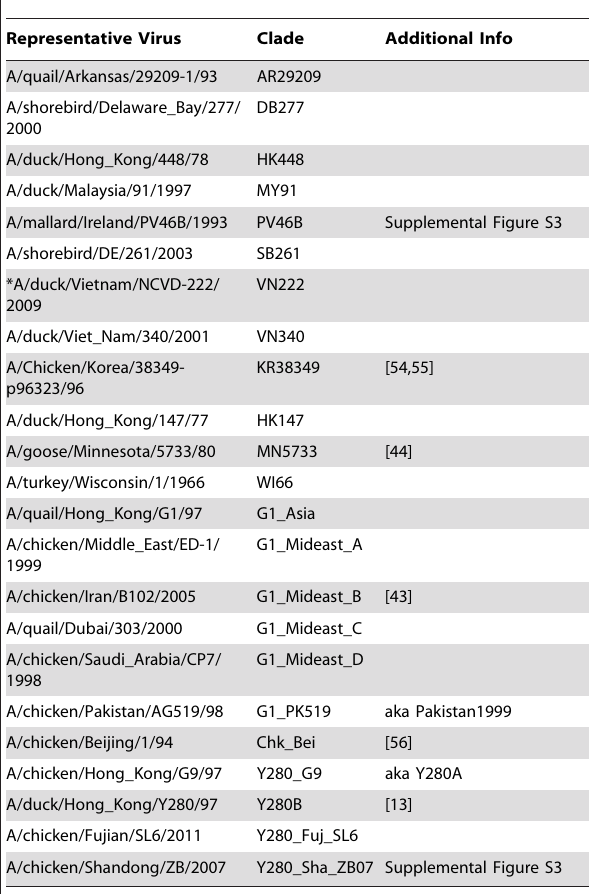
Table 3. Revised 2012 H9N2 nomenclature references.